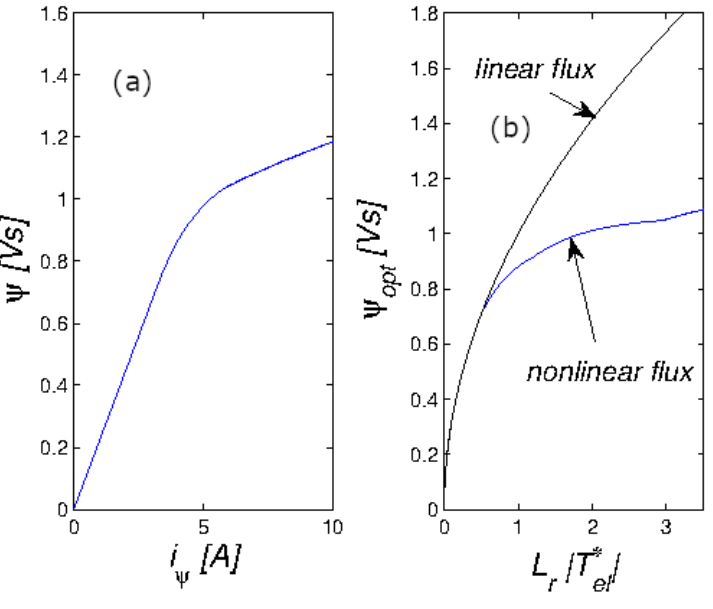
Figure 1. Magnetization curve ( a ); Optimal flux magnitude for constant torque ( b